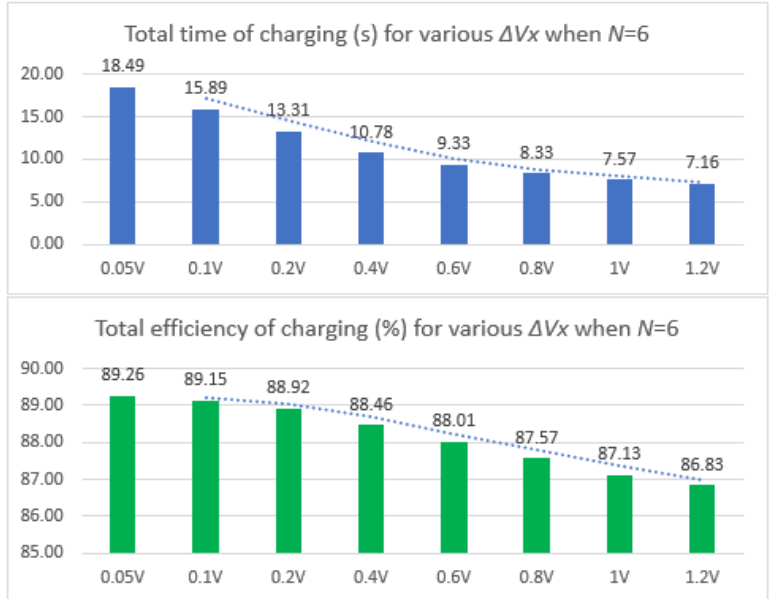
Figure 24. Comparative diagrams of SC circuit charging durations and efficiency at different ∆ V x .